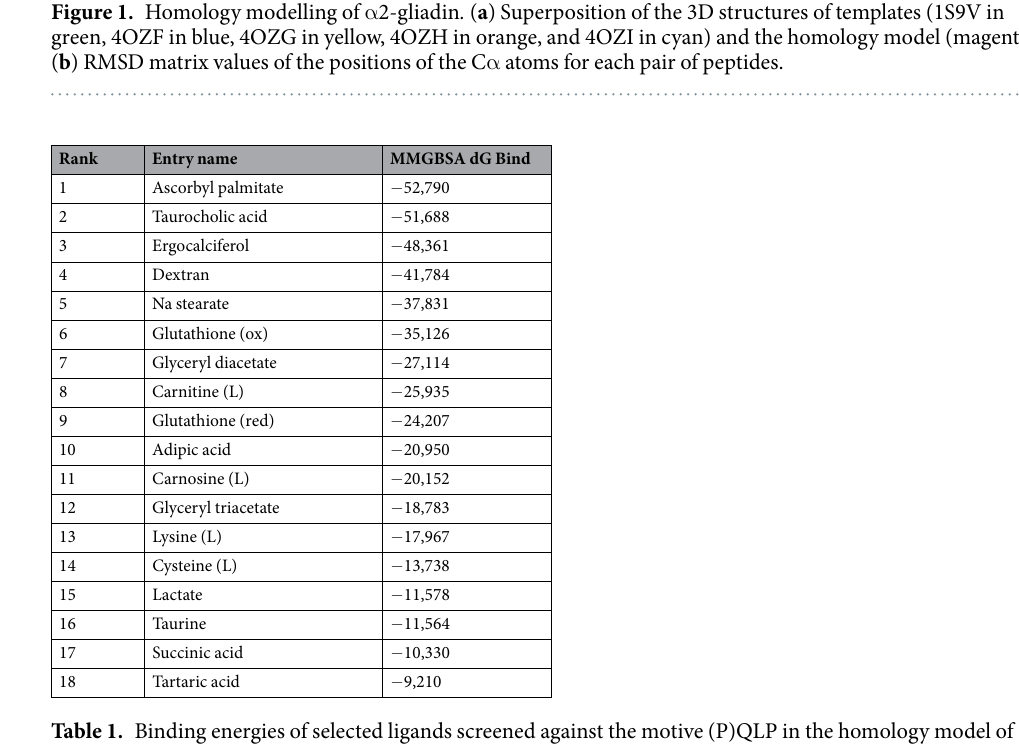
Table 1. Binding energies of selected ligands screened against the motive (P)QLP in the homology model of α